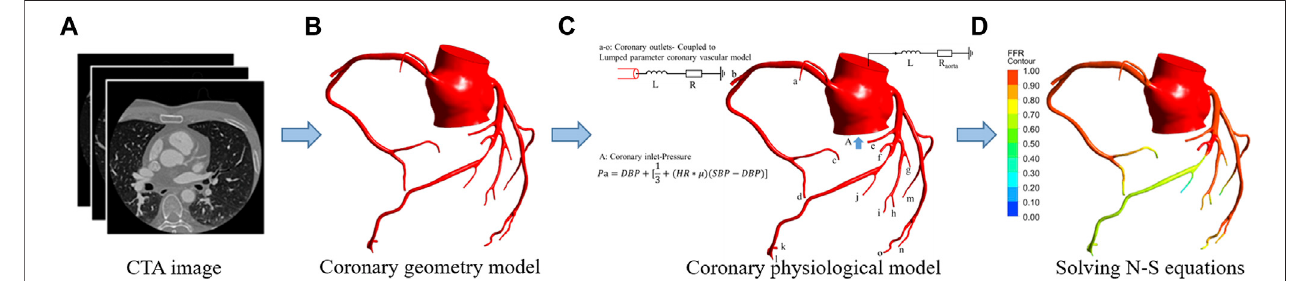
FIGURE 2 | FFR SS calculation fl owchart. (A) CTA image. (B) Coronary geometry model. (C) Coronary physiological model. The 0D model stands for lumped parameter model (a – o) and is composed of resistance “ R" and inductance “ L. ” “ R ” represents the fl ow resistance of coronary branch vessels under the action of blood viscosity, obtained by the allometric scale rate. “ L ” The inertia of blood fl ow, for the branch of the coronary artery, the empirical parameter is 0.05. The 3D model representsthewholecoronarymodel,andthebloodvesselslargerthan1 mmindiameterarecompletelypreserved.The3Dmodelwasobtainedbyreconstruction of coronary CTA images. Among them, in the 0D-3D coupling model, the input is the mean pressure calculated by the physiological formula, and the output is the 0D resistance boundary condition of the coronary artery. (D) Solved N-S equations.0D and 3D coupling diagram.